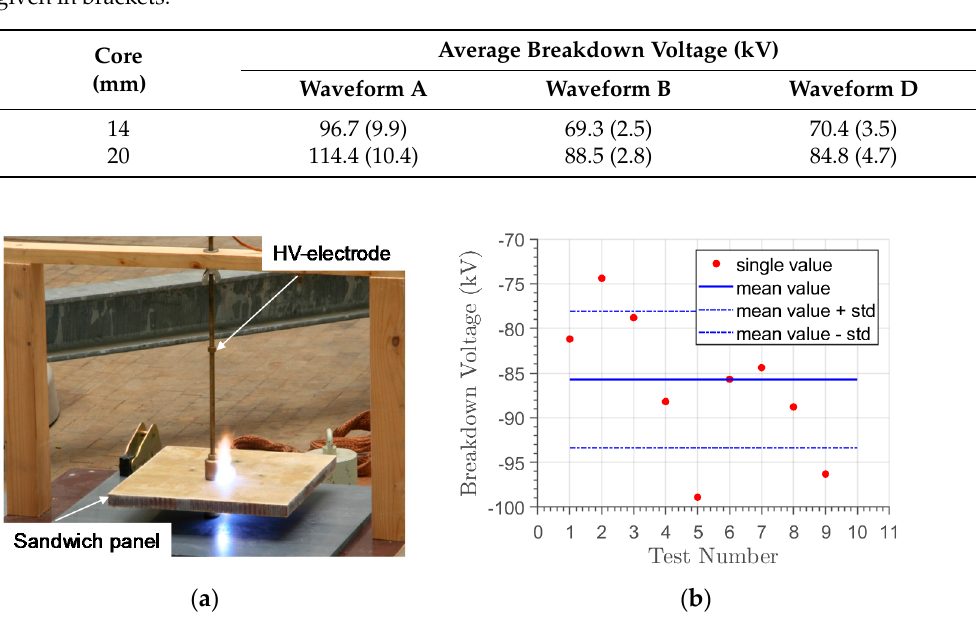
Figure 4. ( a ) Test setup with sandwich sample; ( b ) Breakdown voltage of radome sample with the core thickness of 20 mm using waveform D. Table 1. Average breakdown voltage for the 2 types of sandwich panels. The standard deviations are given in brackets.